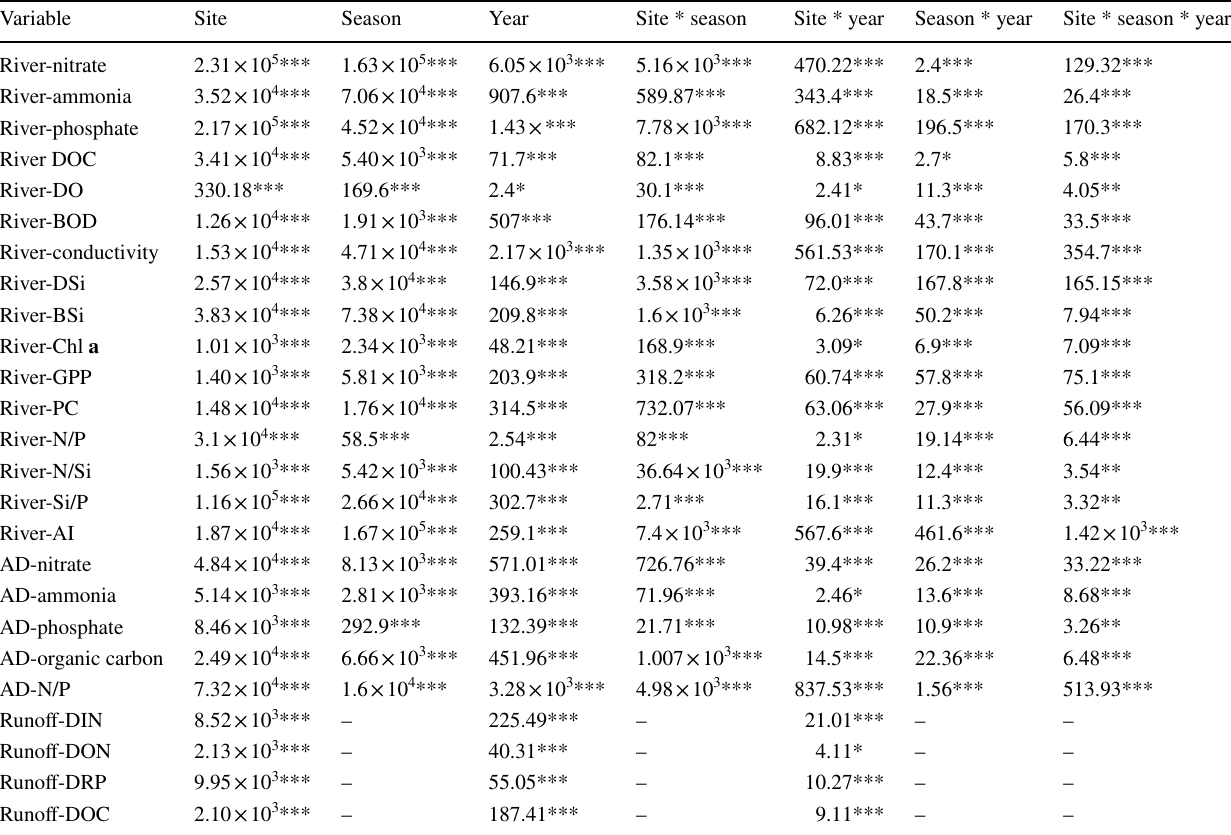
Table 2 F ratios obtained from analysis of variance (ANOVA) indicating significant effect of site, season, year and their interactions on AD, run- off and river water quality